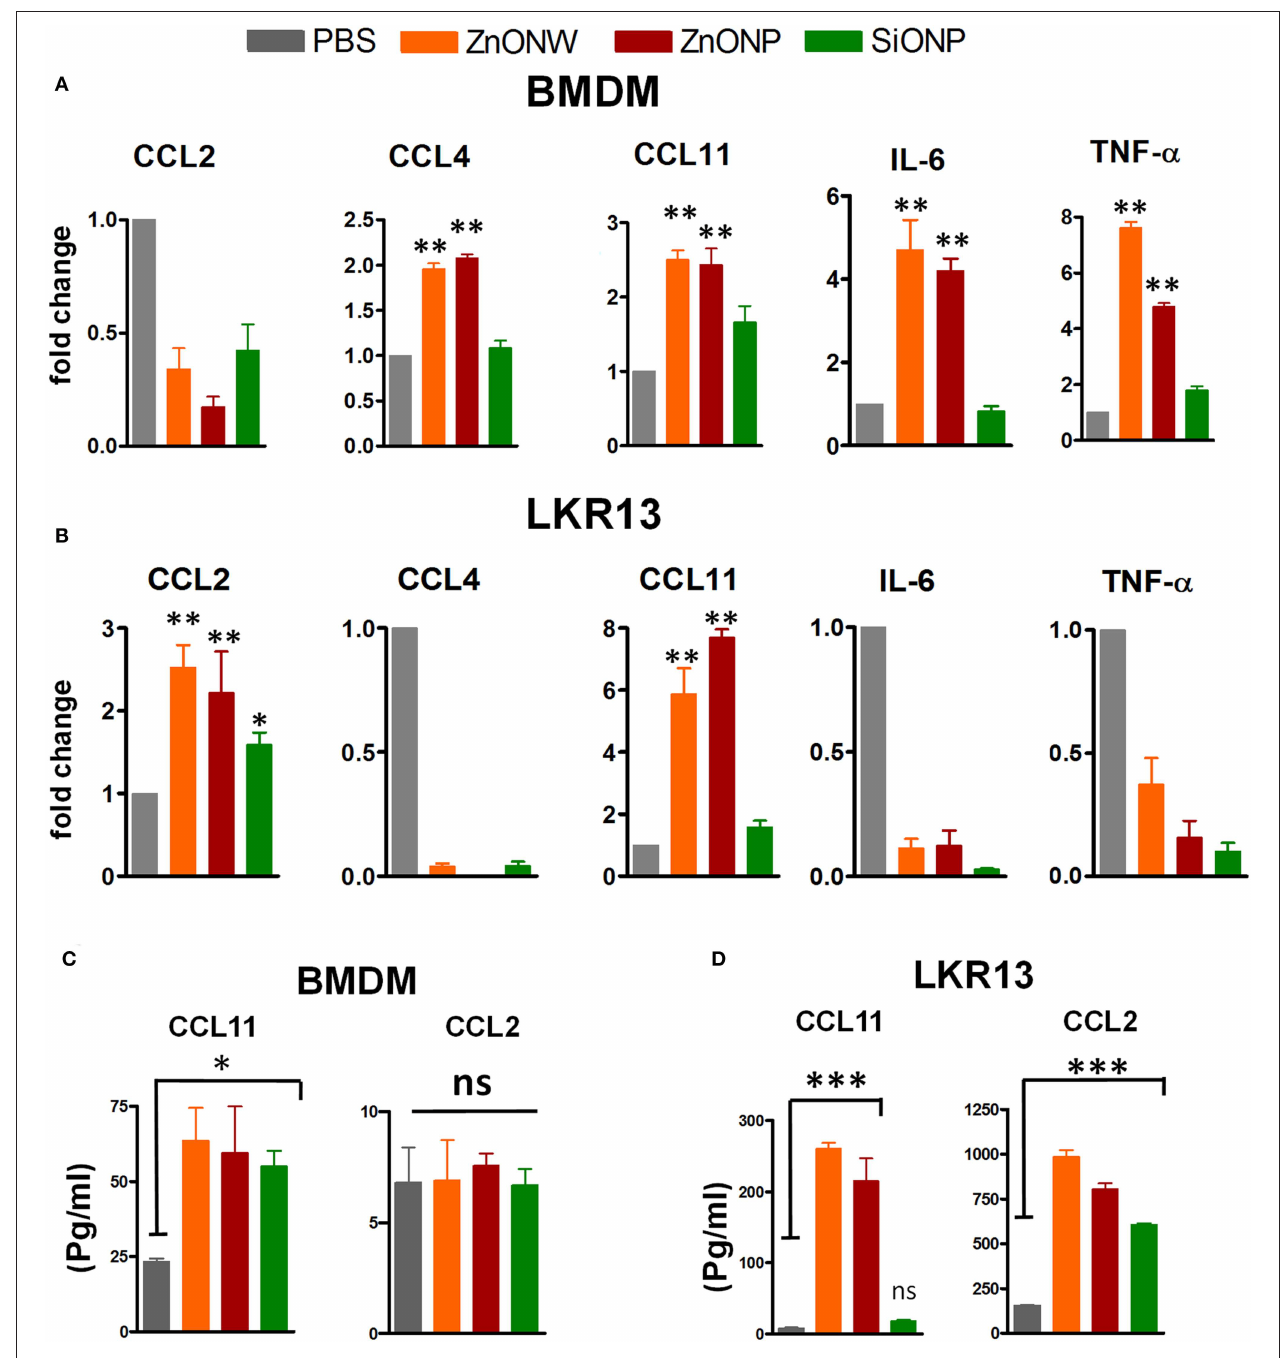
FIGURE 6 | Regulation of inflammatory mediators by ZnONWs exposure. BMDMs were treated with LPS (10ng/ml) or PBS for 3h and washed and then cells were treated with nano particles or PBS for 6h and) were assessed for production of chemokines and cytokines in vitro . mRNA levels were analyzed in PBS or particles treated cells using qRT-PCR. Levels of CCL2, CCL4, CCL11, IL-6 (in LPS primed cells) and TNF- α (without LPS priming) transcripts were measured in total RNA and expressed as fold change over PBS treated cells for BMDM (A) . Lung epithelial cell line, LKR-13 were treated with nano particles for 6h with no prior LPS priming and the mRNA levels of indicated chemokines and cytokines was analyzed (B) Data are representative of three independent experiments in triplicate cultures and expressed as ± SEM. * P < 0.05, ** P < 0.01. The levels of CCL11 and CCL2 proteins were determined in the culture supernatants from the experiments in a and b by ELISA (C,D) . Data are from one of three experiments in triplicate cultures and expressed as ± SEM. * P < 0.05, *** P < 0.0001.